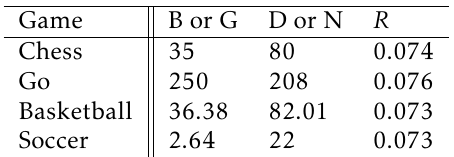
Table 2. Measures of game refinement for board games and sports games